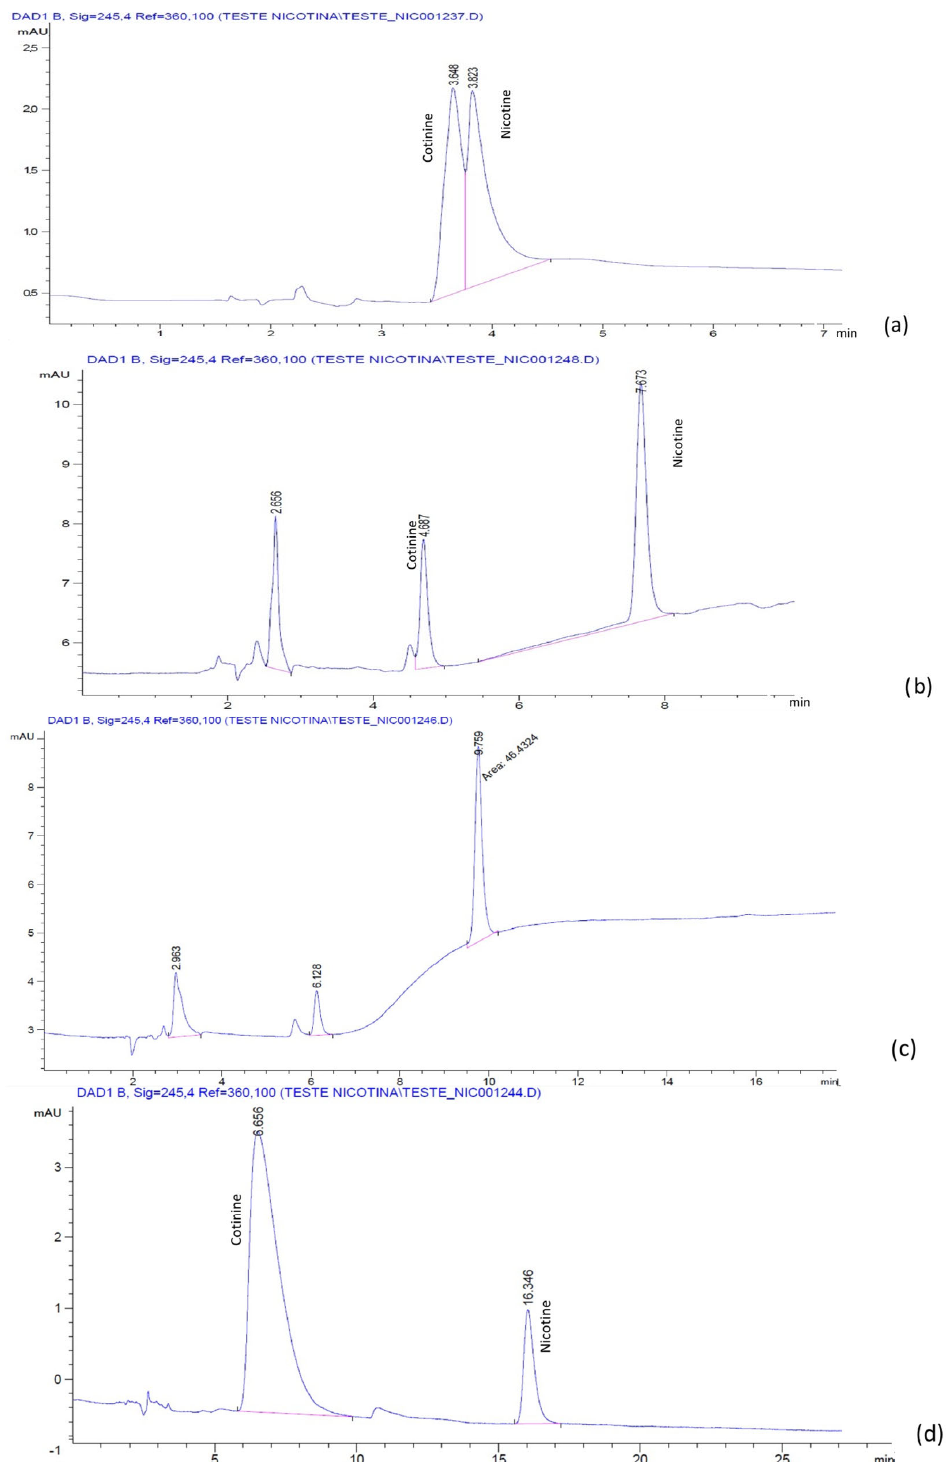
Figure 1. Chromatograms of nicotine and cotinine in human plasma with mobile phases containing H 2 O:ACN 60:40 (pH 2.5 with H 3 PO 4 ): ( a ) without additive; ( b ) with 0.5 mM BMIM[BF 4 ]; ( c ) with 1.0 mM BMIM[BF 4 ]; ( d ) with 2.5 mM BMIM[BF 4